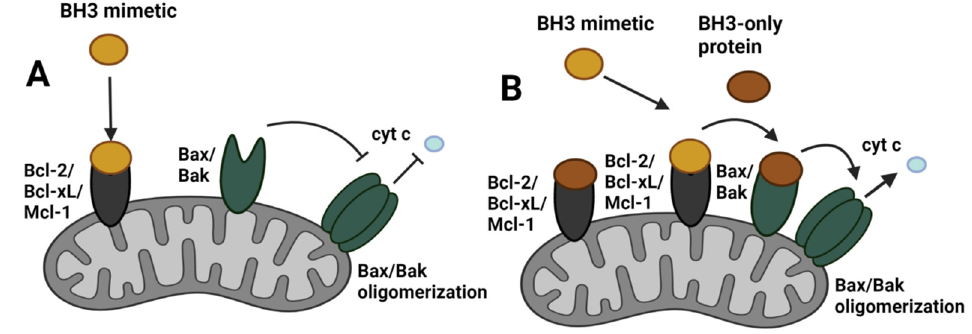
Figure 6. Priming of mitochondria for the activity of BH3 mimetics. ( A ) In the unprimed state, the low BH3-only protein load does not lead to apoptosis induction upon BH3 mimetic binding ( B ). In the primed state, high BH3-only protein load enables translocation of the BH3-only protein upon the binding of the BH3 mimetic, which leads to Bax/Bak activation, oligomerization, and cytochrome c release. Created with BioRender.com (accessed on 5 December 2021).